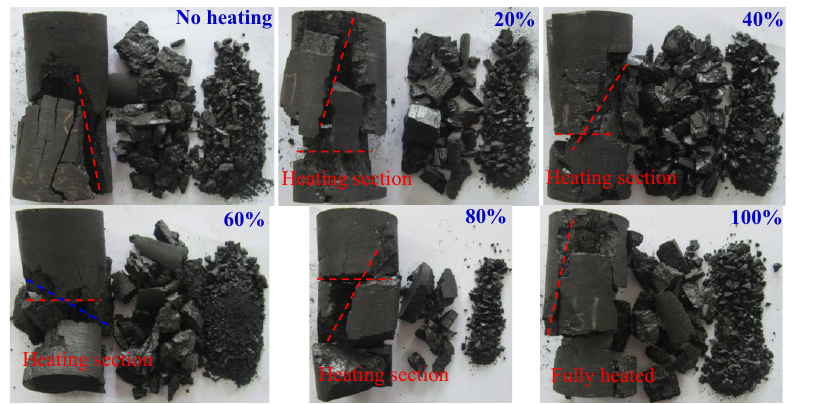
Figure 15. Failure mode of coal sample segmented heating to 300